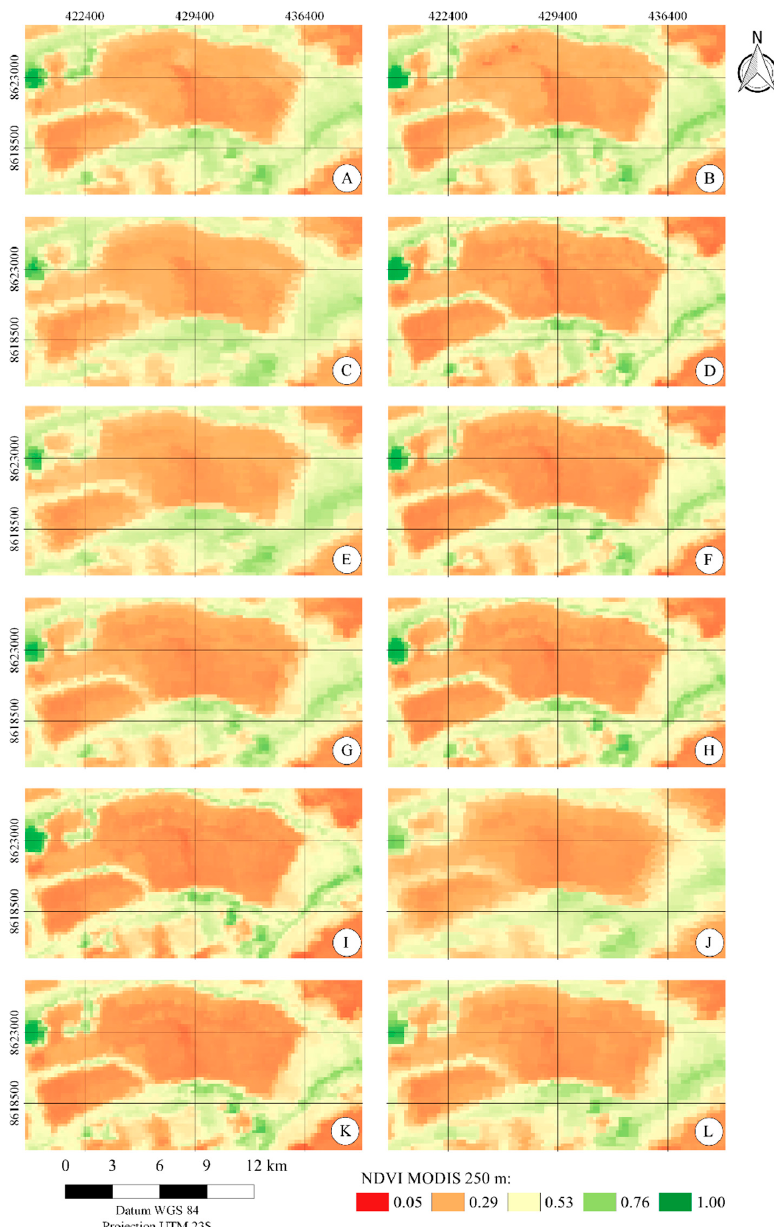
Figure 6. NDVI images estimated from the product MOD09QG of the MODIS sensor, with a spatial resolution of 250 m, on the following days: 07/29/2017 ( A ); 30 July 2017 ( B ); 31 July 2017 ( C ); 3 August 2017 ( D ); 4 August 2017 ( E ); 5 August 2017 ( F ); 6 August 2017 ( G ); 8 August 2017 ( H ); 10 August 2017 ( I ); 11 August 2017 ( J ); 12 August 2017 ( K ); 13 August 2017 ( L ).